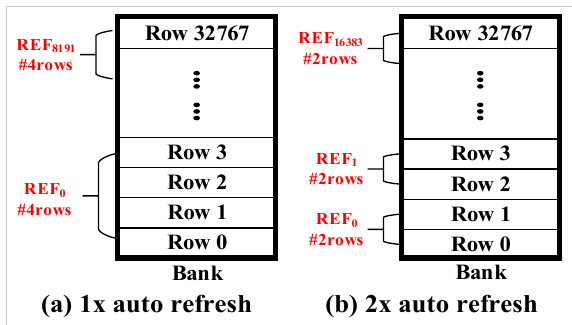
Figure 5. Illustrations of ( a ) 1x and ( b ) 2x auto-refresh.